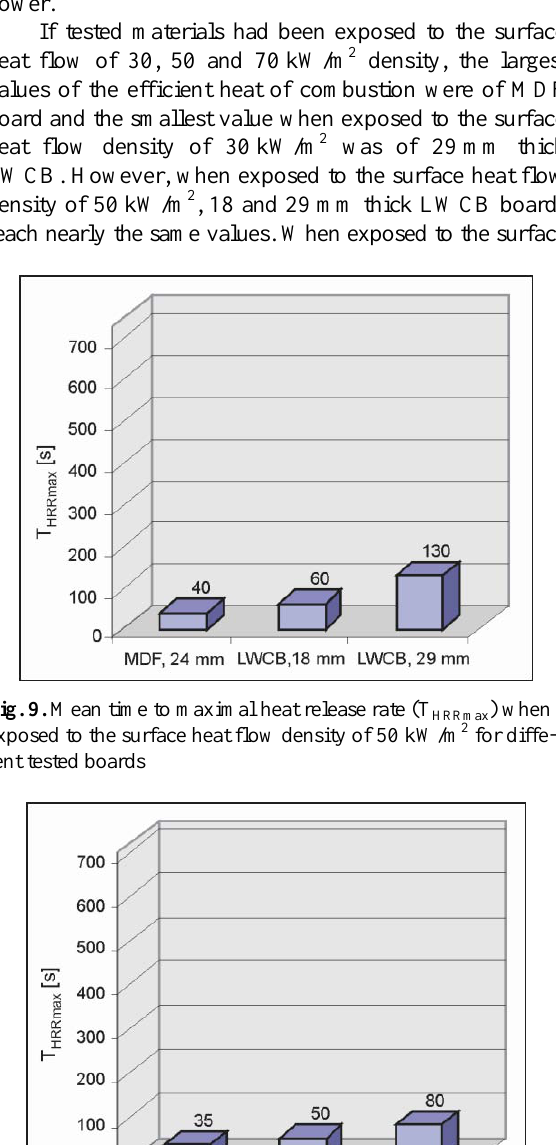
Fig. 6. The mean value of maximal heat release rate (HRR max ) when exposed to the surface heat flow density of 50 kW/m 2 for different tested boards